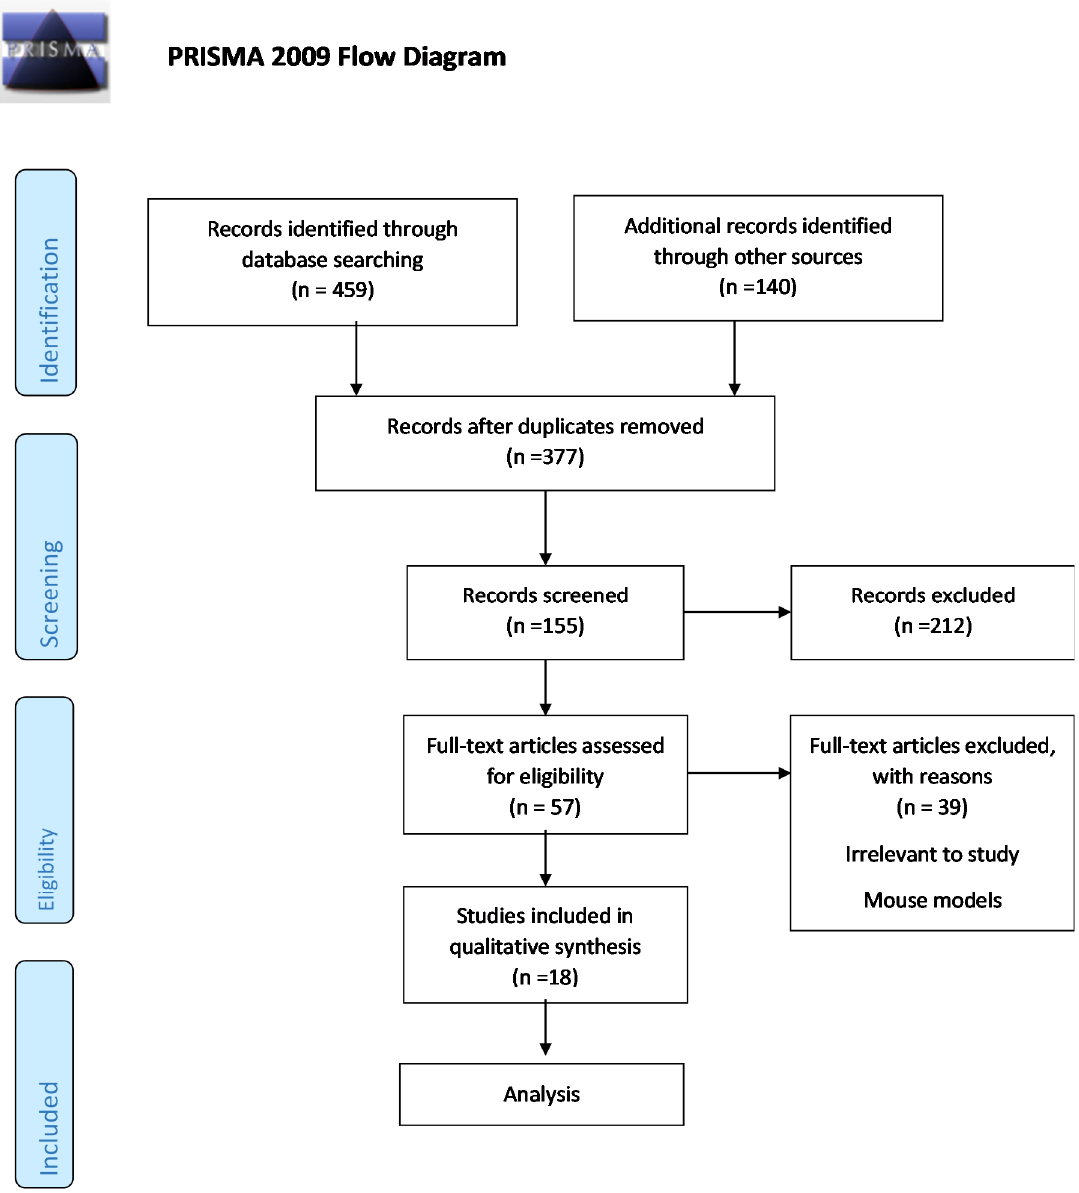
Figure 1. PRISMA Flow Diagram. The following flow diagram indicates the identification, screening, eligibility and studies included in this review and also studies and the reasons for their exclusion from the study.